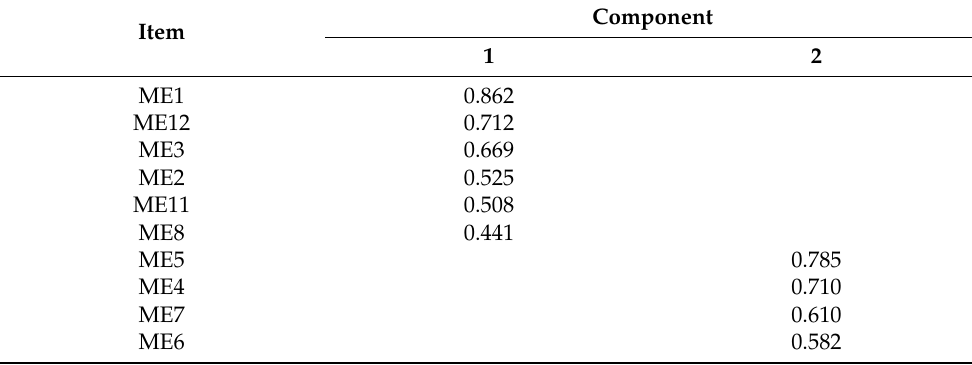
Table A2. The factor loading of each item after rotation.